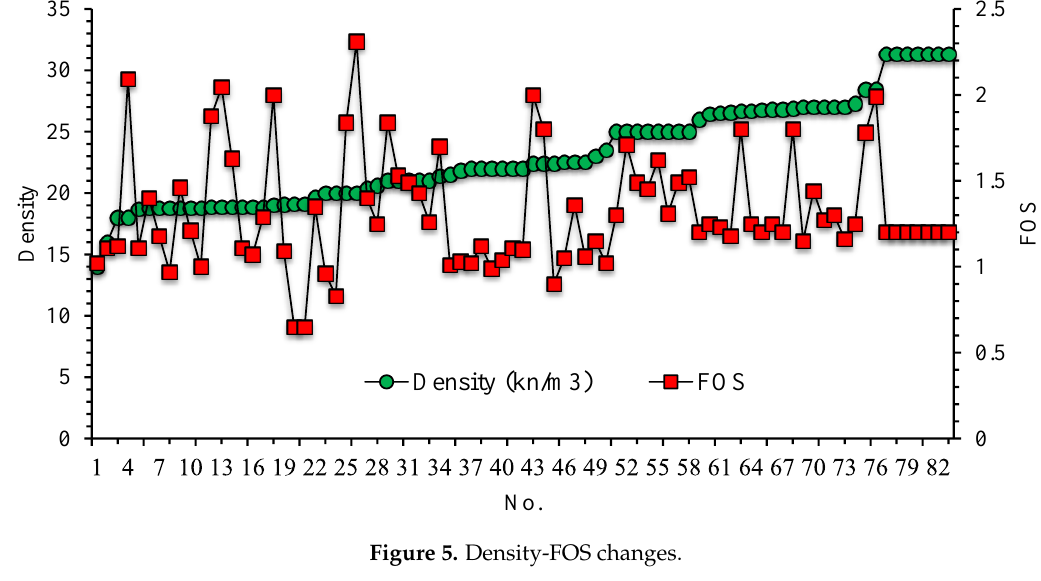
Figure 5. Density-FOS changes .